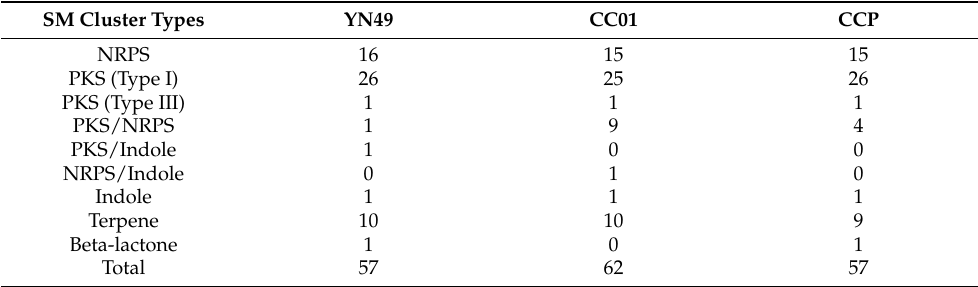
Table 3. Secondary metabolite biosynthetic gene clusters in C. cassiicola YN49, CC01 and CCP.